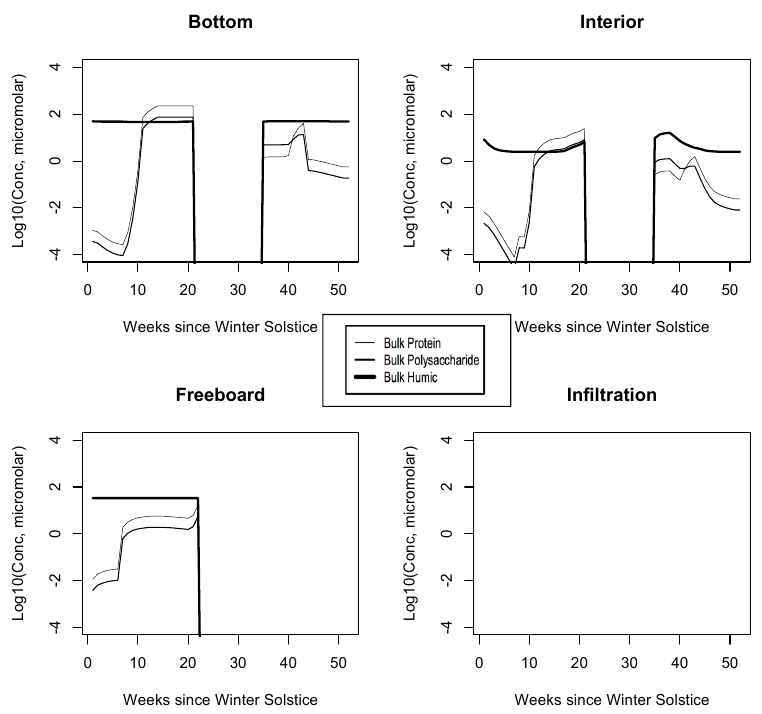
Figure 12. Central Arctic, caption as in Figure